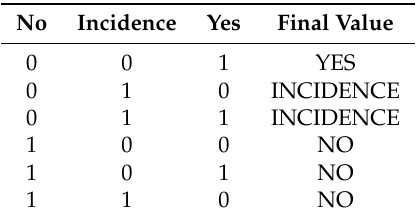
Table 2. AND operation between the